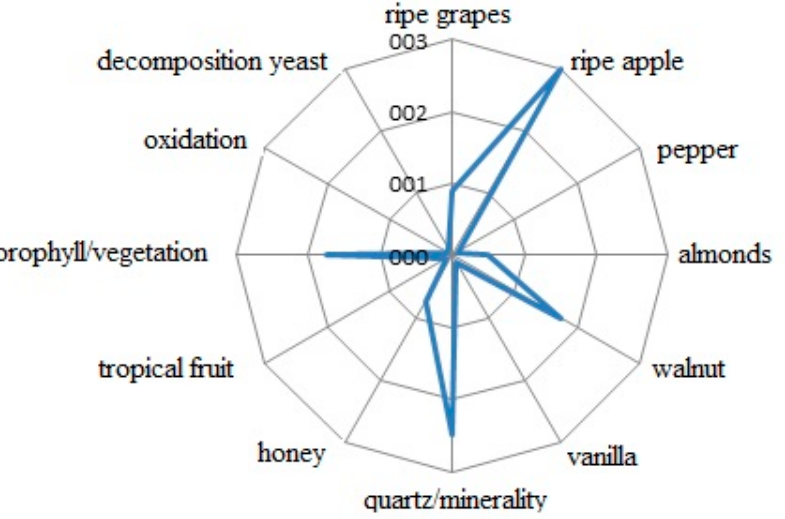
Figure 7. Evaluation of the specific taste descriptors for the W 2016 variant processed by targeted